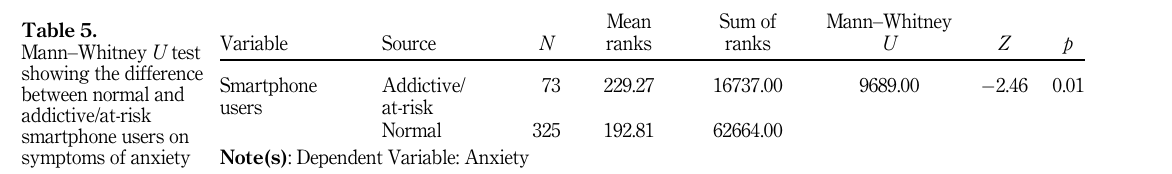
Table 4. Mann – Whitney U test showing the difference between normal and addictive/at-risk smartphone users on symptoms of depression